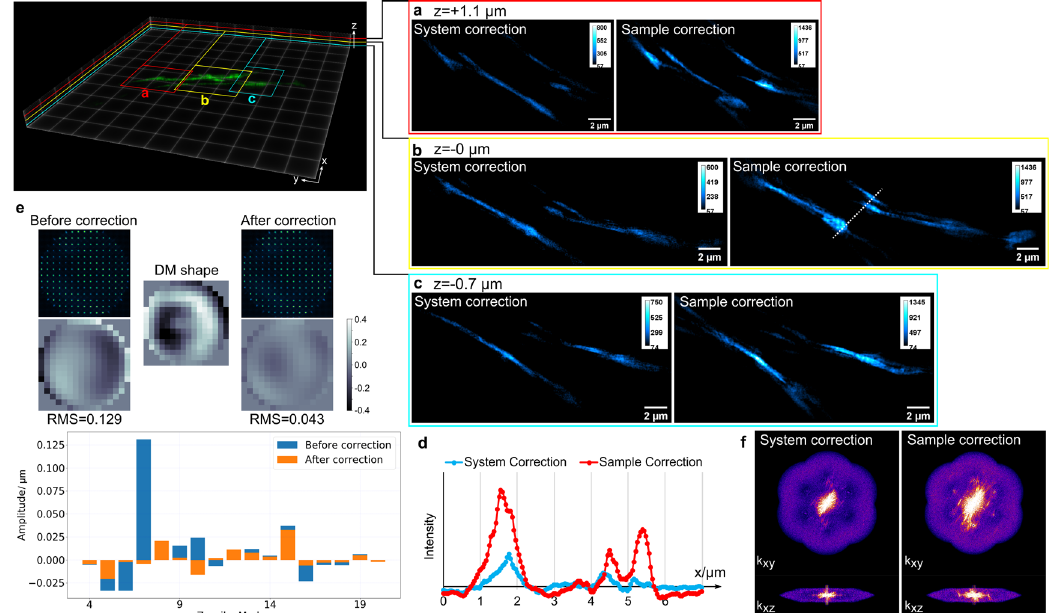
Fig. 10 Live C. elegans with TBH-1::GFP expressed in RIC interneurons in the lateral ganglion. The 3D-SIM images of the neural fi ber before and after sample aberration correction at different z positions: a z = + 1.1 µ m. b z = 0.0 µ m. c z = − 0.7 µ m. d The intensity pro fi les plotted along the white dotted line in 3D-SIM images. e The measured wavefronts and their Zernike mode decompositions before and after sample aberration correction and the corrective wavefront applied on the DM (units in microns). f Effective OTF of 3D-SIM images before and after sample aberration